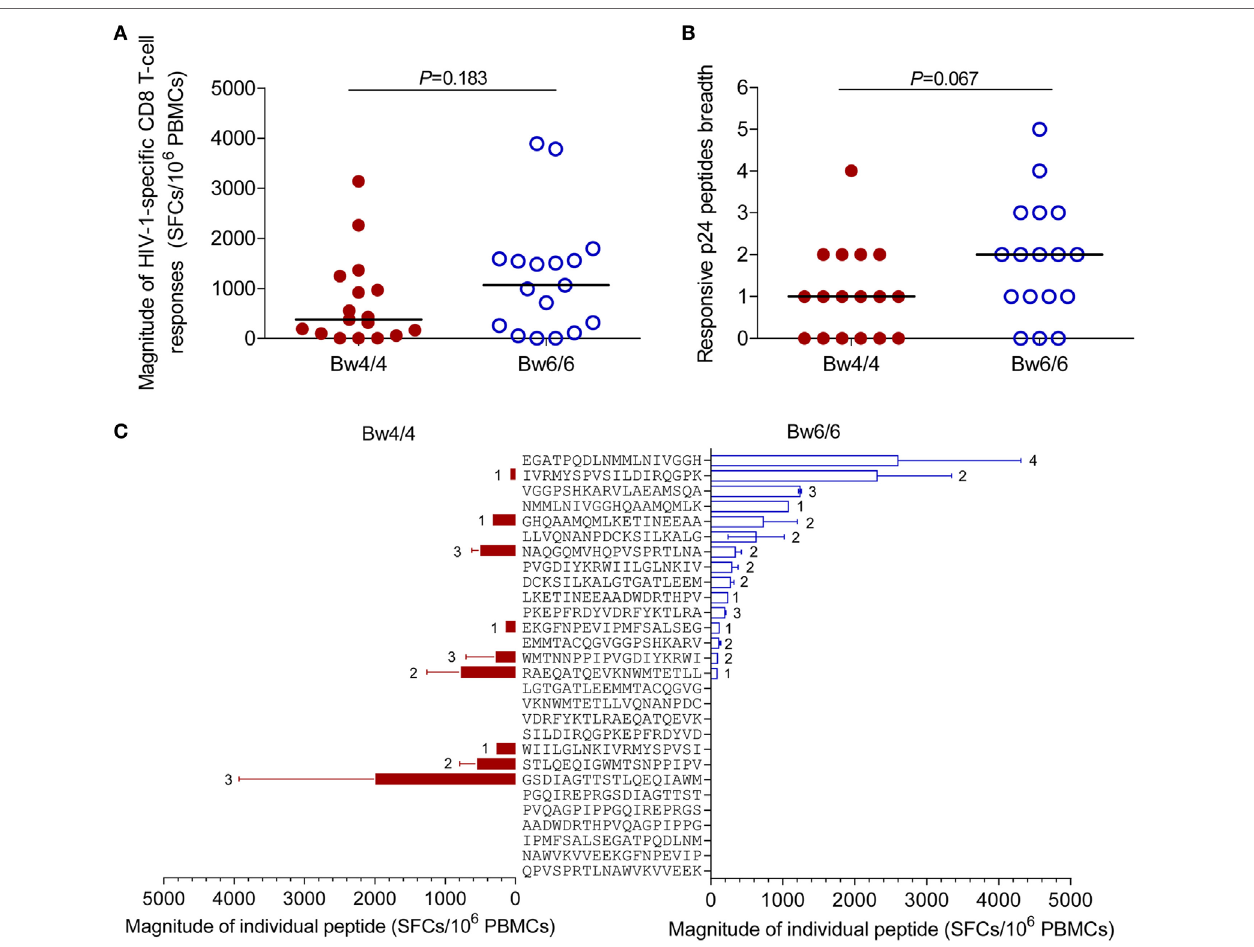
FigUre 6 | Comparison of human immunodeficiency virus type 1 (HIV-1)-specific CD8 T-cell responses. Comparison of the magnitude (a) and the breadth (B) of the p24-specific CD8 T-cell responses induced in patients homozygous for Bw4 or Bw6 ; (c) Differences in peptide mapping for patients homozygous for Bw4 (red) and Bw6 (blue). The location of individual peptide was shown in Table S1 in Supplementary Material. The number beside the bar indicates the number of patients responding to the peptide concerned. Unpaired, non-parametric Mann–Whitney U tests were used to compare groups, with P < 0.05 considered